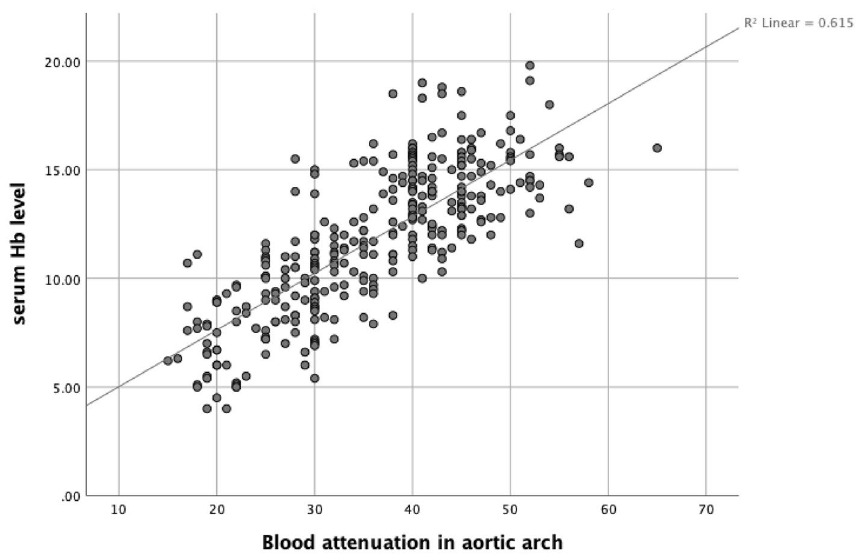
Figure 1. Relation between the blood attenuation in the aortic arch and serum Hb level in 325 subjects. The correlation coefficient was 0.78 (R 2 : 0.61). Hb